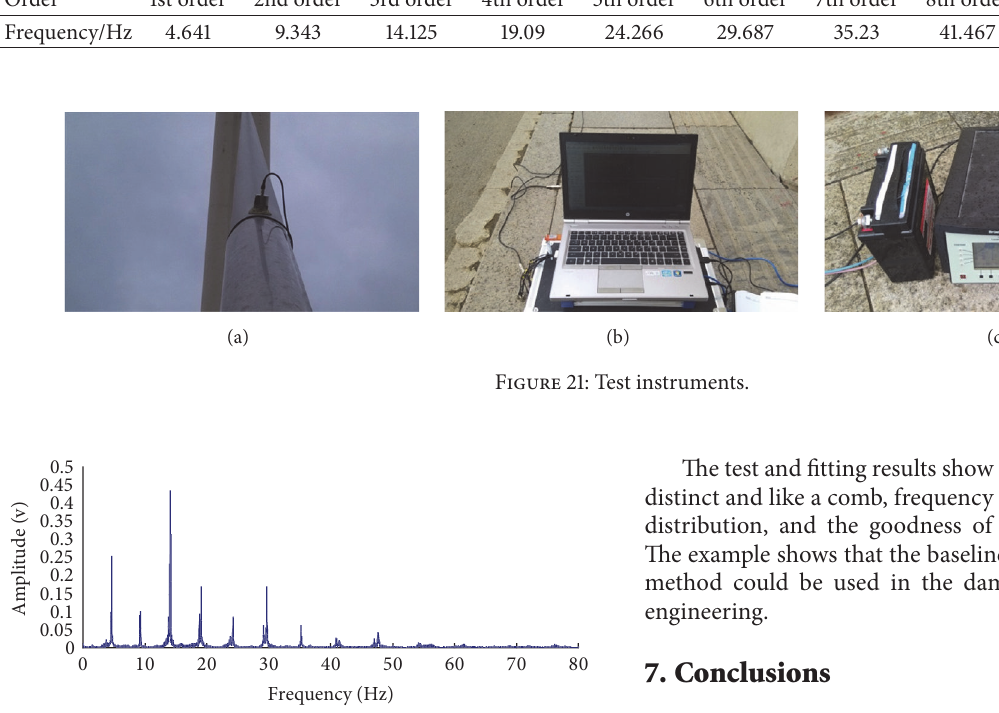
Figure 22: Frequency spectrum of the transverse vibration of the cable.